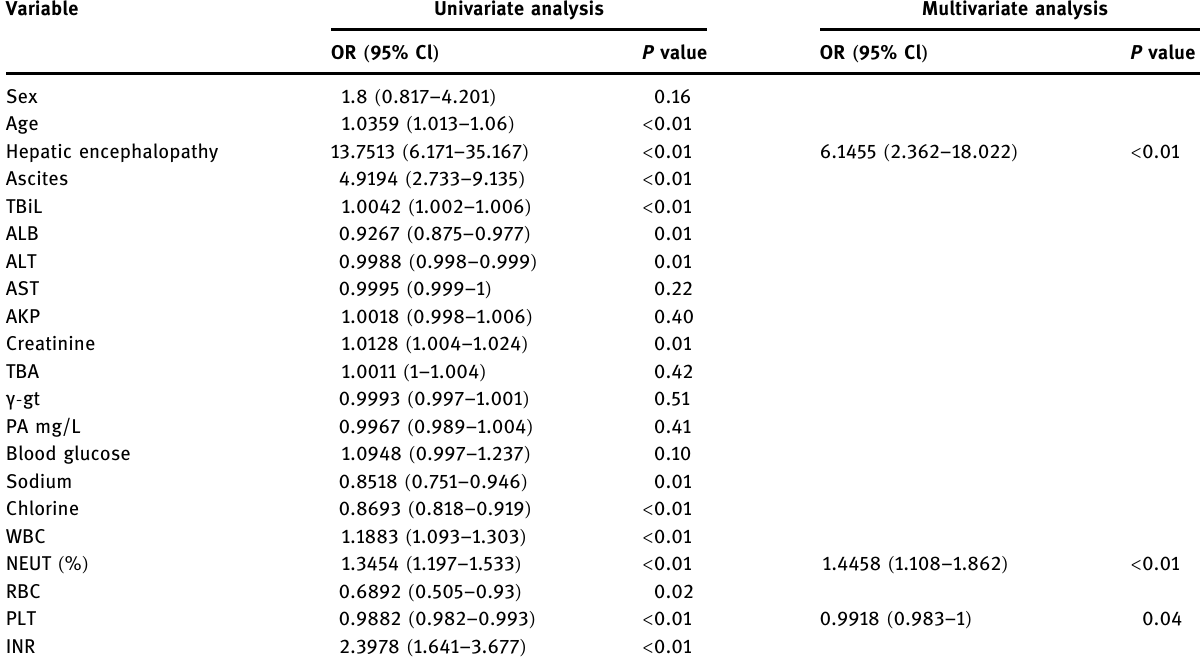
Table 3: Univariate and multivariate logistic regression